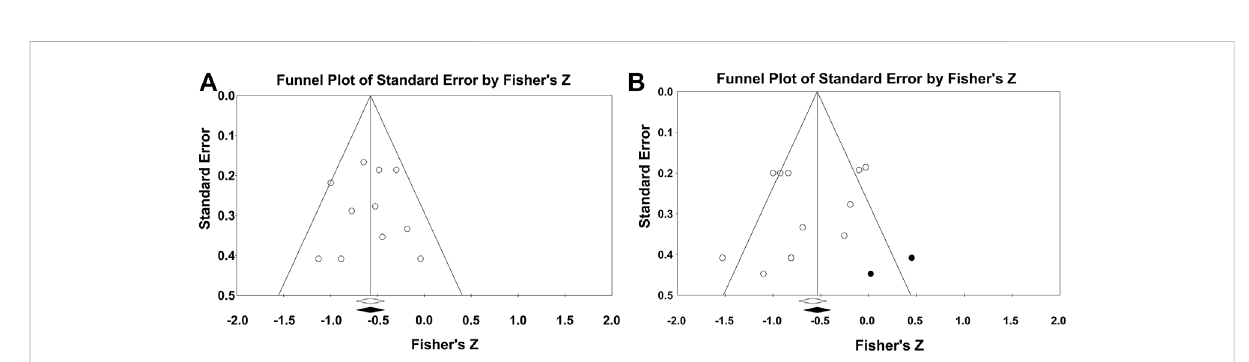
FIGURE 6 Vertical stiffness (A) and leg stiffness (B) , funnel plot with running economy